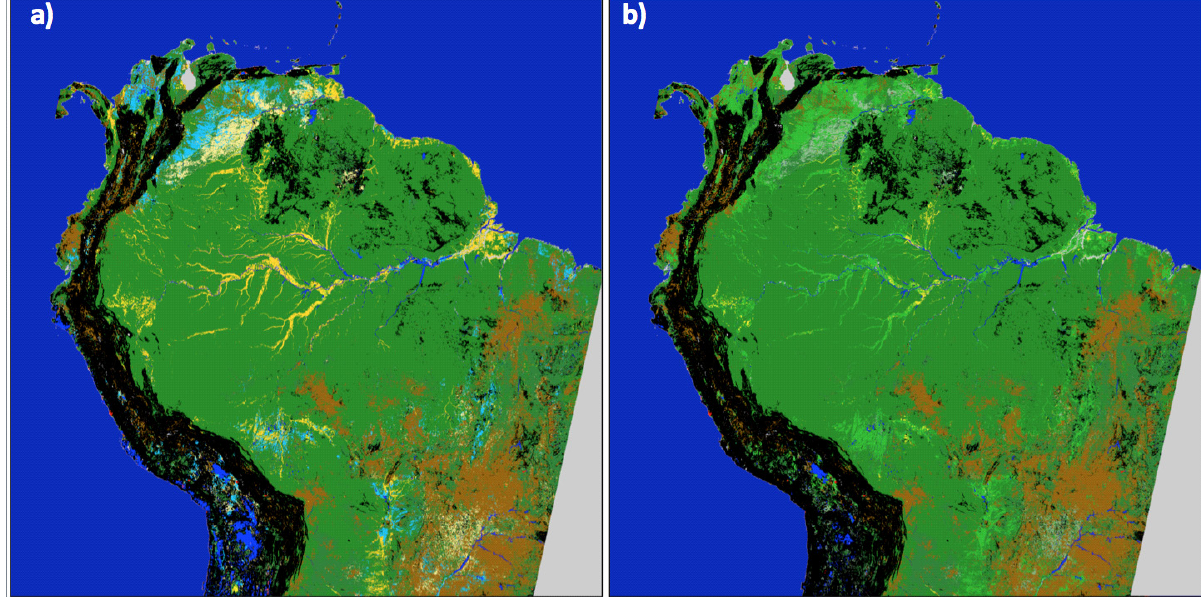
Figure 7. Inundation classification late-2006 to mid-2010; same location as shown in Figure 3. ( a ) maximum inundation, ( b ) minimum inundation. Black-topographically excluded; dark blue : open water; light blue : open water maximum; green : not inundated; yellow : inundated vegetation; light yellow : inundated vegetation maximum; brown : croplands from GlobCover 2009; grey :